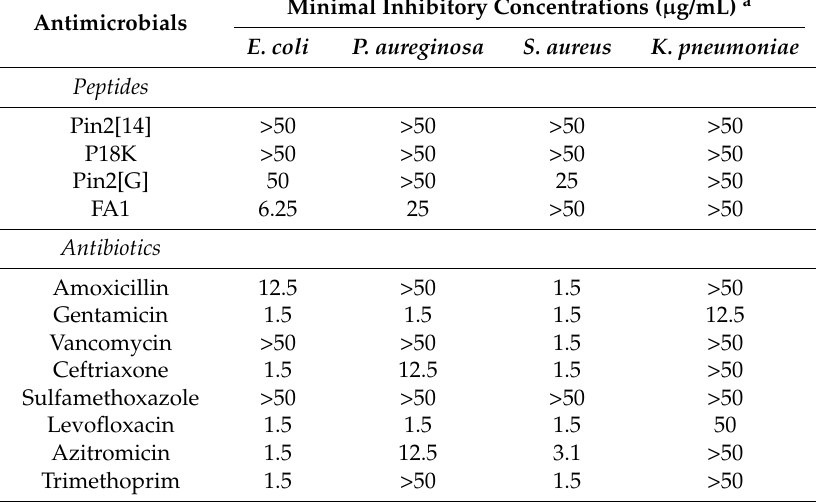
Table 2. Minimal inhibitory concentration of peptides and antibiotics against E. coli , P. aureginosa, S. aureus and K. pneumoniae